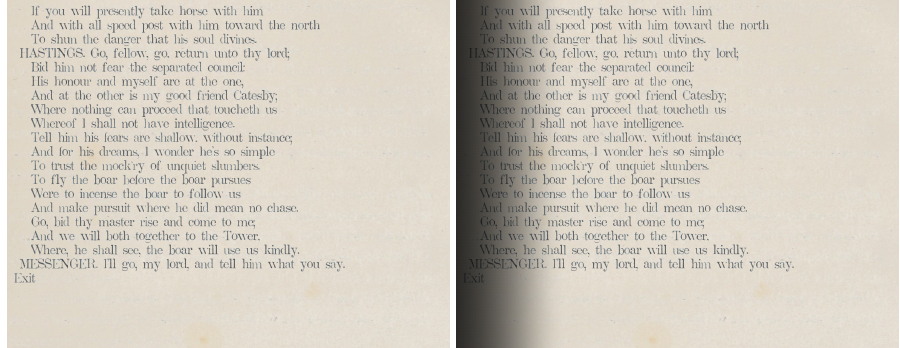
Figure 10. Examples of nonlinear illumination model defect. ( Left ) original image. ( Right ) degraded image with illumination defect applied on the left